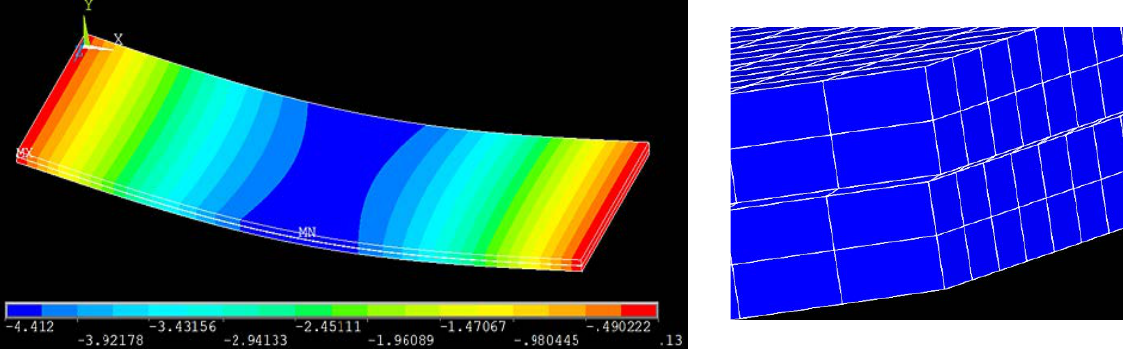
Fig. 18. The deflected shape reminds the deflection curve of monolitic simply supported uniformly loaded panel with maximal midspan deflection 4.41 mm. But the deformed shape of interlayer´s element in Fig. 18b reflects limited shear coupling of the individual glass plies and illustrates in their mutual “slide”. Therefore, the model acts actually as a laminated